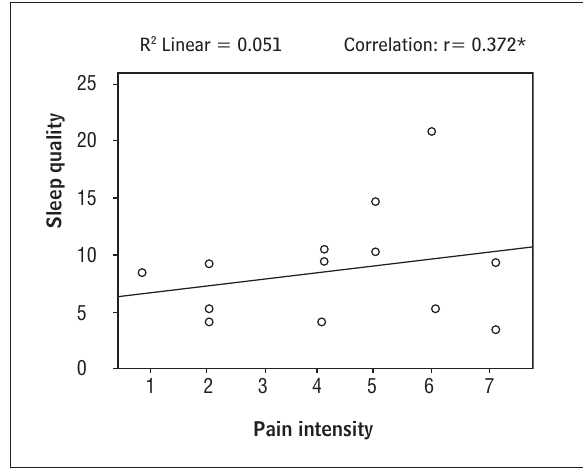
Figure 1 - Correlation between pain intensity and sleep quality (r = 0.372; P = 0.043) Note = * Statistically signi fi cant (P <